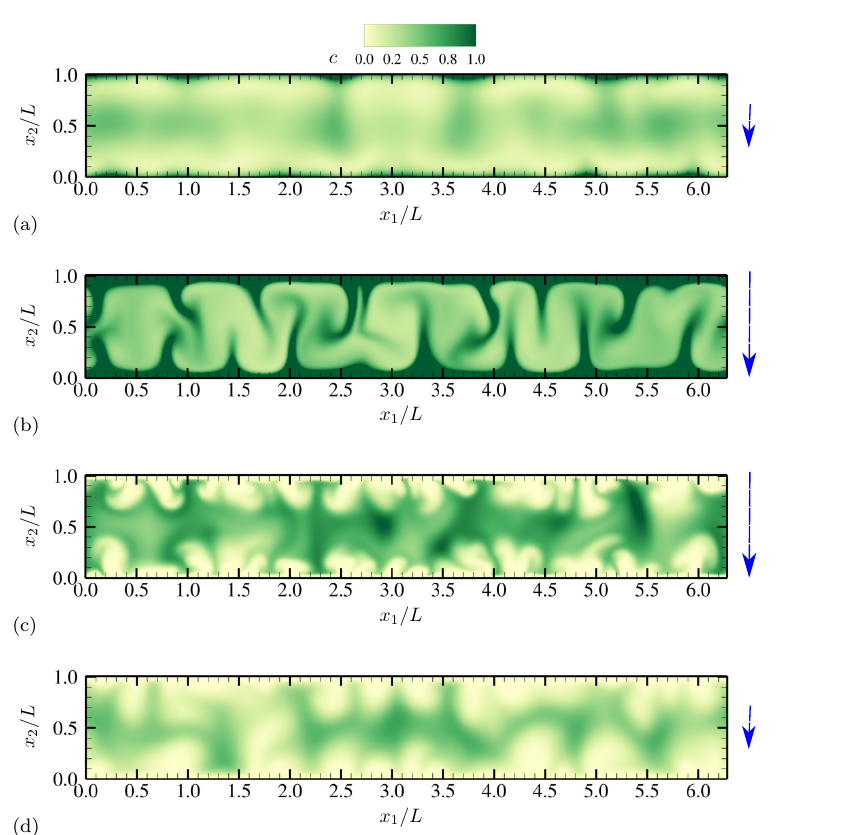
Figure 3. Time series of salt concentration c for half an oscillation period at ( a ) θ = 0.64 π , ( b ) 0.88 π , ( c ) 1.12 π and ( d ) 1.4 π . The vertical arrows denote the direction and relative magnitude (not to scale) of the applied electric field. The diffusivity ratio is D − / D + =